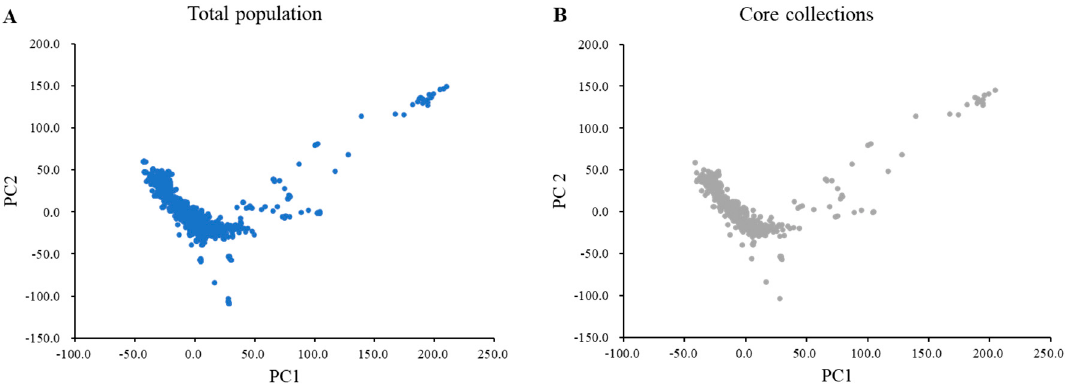
Figure 1. Principal component analysis of the total population and core collection with 180 K Axiom ® SoyaSNP. ( A ) Blue indicates the total wild soybean accessions (n = 1467). ( B ) Gray represents 408 selected core collections.